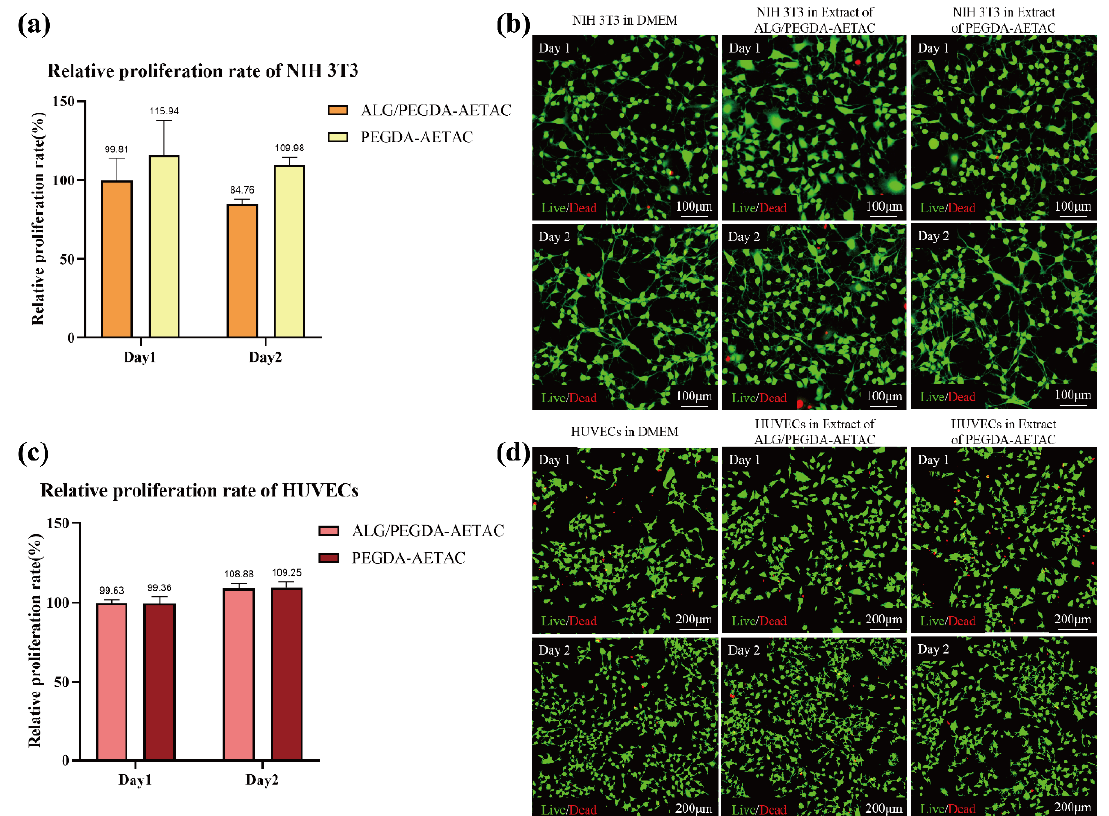
Figure 3. ( a ) The relative proliferation rate of NIH 3T3 cells in the extracts of ALG/PEGDA-AETAC and PEGDA-AETAC. ( b ) Live/dead staining images of NIH 3T3 cells after 24 h and 48 h of culture in culture medium, ALG/PEGDA-AETAC hydrogel extract, and PEGDA-AETAC hydrogel extract. ( c ) The relative proliferation rate of HUVECs in the extracts of ALG/PEGDA-AETAC and PEGDA-AETAC. ( d ) Live/dead staining images of HUVECs after 24 h and 48 h of culture in culture medium, ALG/PEGDA-AETAC hydrogel extract, and PEGDA-AETAC hydrogel extract.